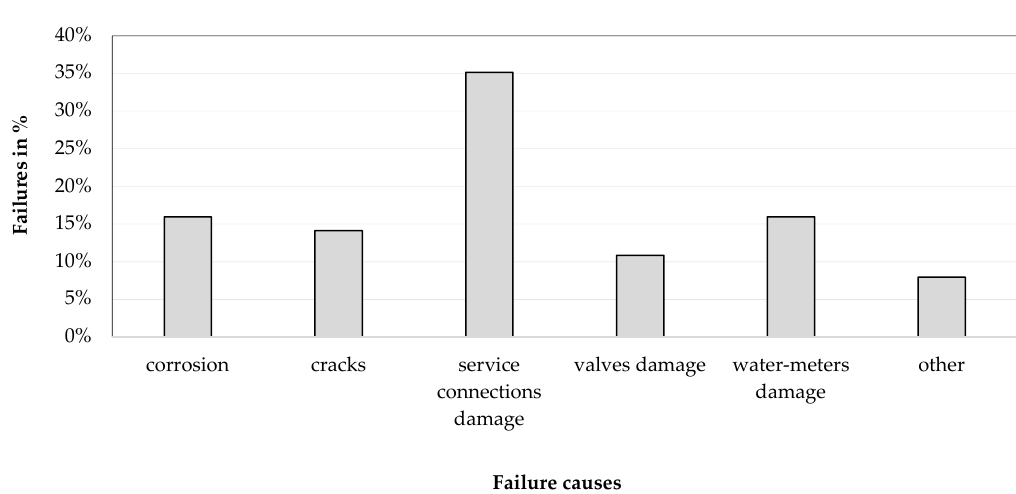
Figure 3. Percentage of the failure cause in the water supply network.